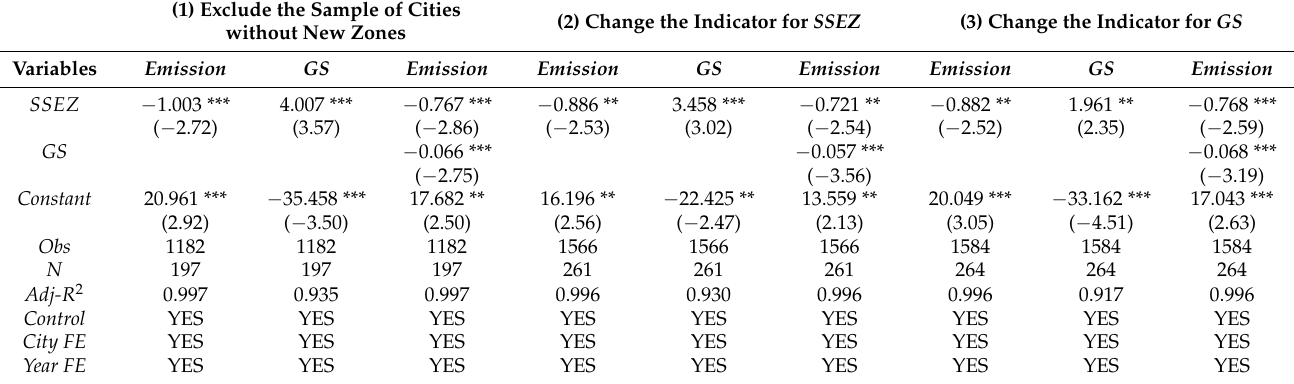
Table 5. Results of robustness